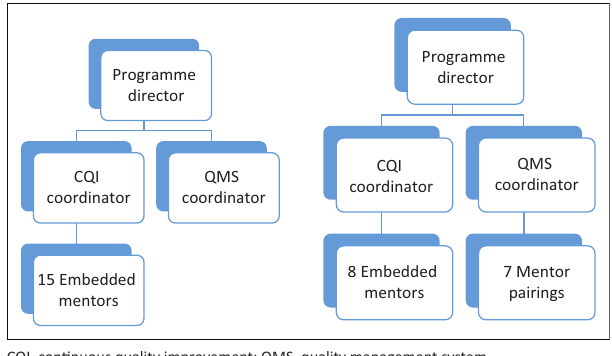
FIGURE 1: Comparison between the standard and intensified mentorship structures in University of Maryland, Baltimore from April 2016 to March 2019, Kenya.